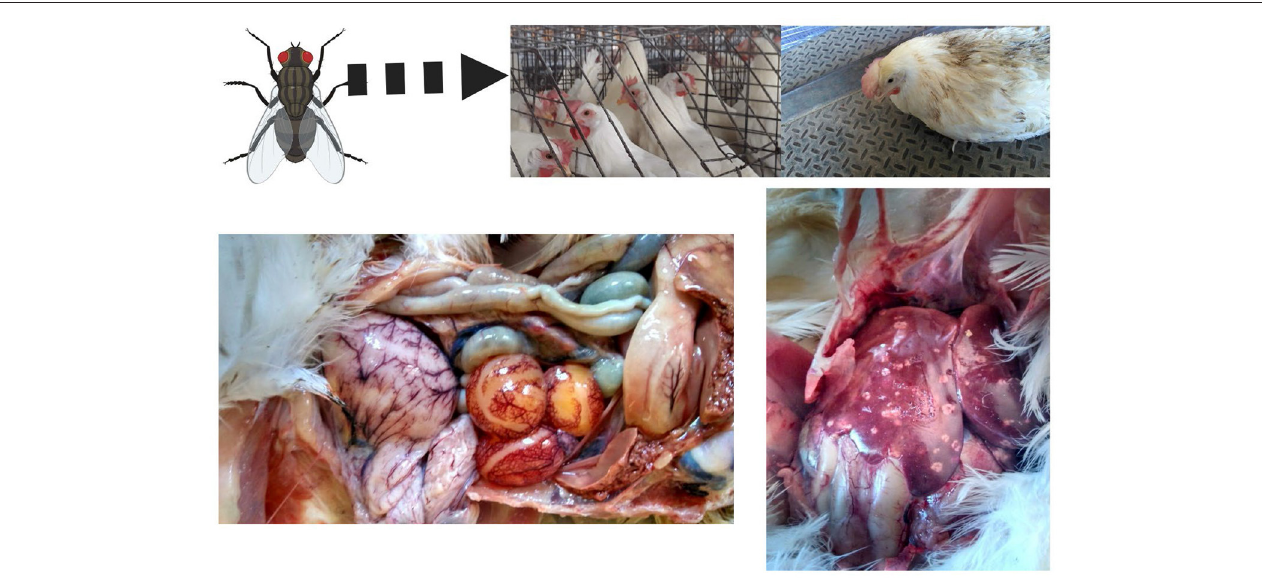
FIGURE 5 | Field case of histomonosis in a layer operation. Turkeys are especially susceptible to Histomonas meleagridis infection, although other gallinaceous birds such as chickens, pheasants, and peafowls can be affected. In this figure, a cage layer hen in a commercial operation with multiple ages and a fly problem developed clinical signs and lesions of histomonosis without the presence of Heterakis spp. (Created with